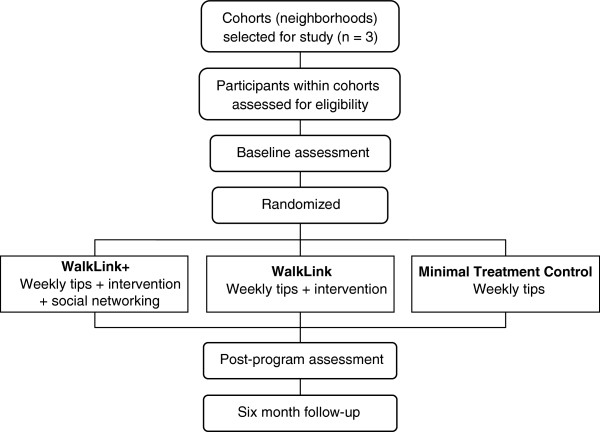
Study flow chart.